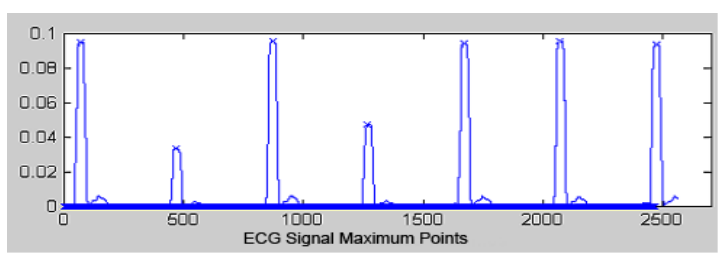
Figure 7. Maximum points.